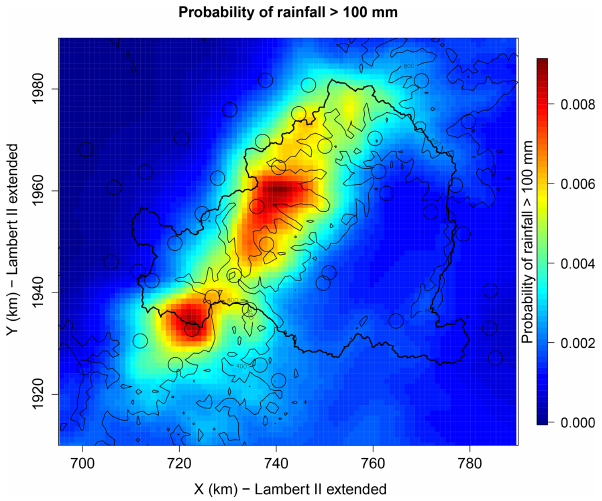
Figure 13. Map of the probability of daily rainfall exceeding 100mm. The points show the locations of the